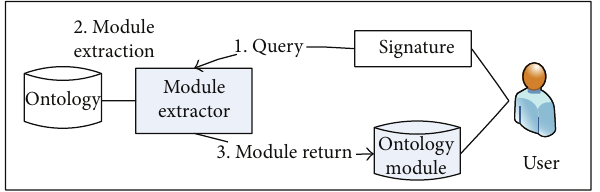
Figure 1: The proposed